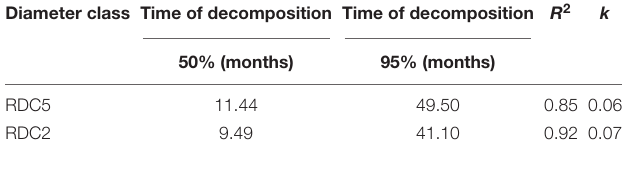
TABLE 2 | Decomposition parameters and time required for two fine-root diameter groups to decay (t 50 and t 95 dry matter loss). Diameter class Time of decomposition Time of decomposition R